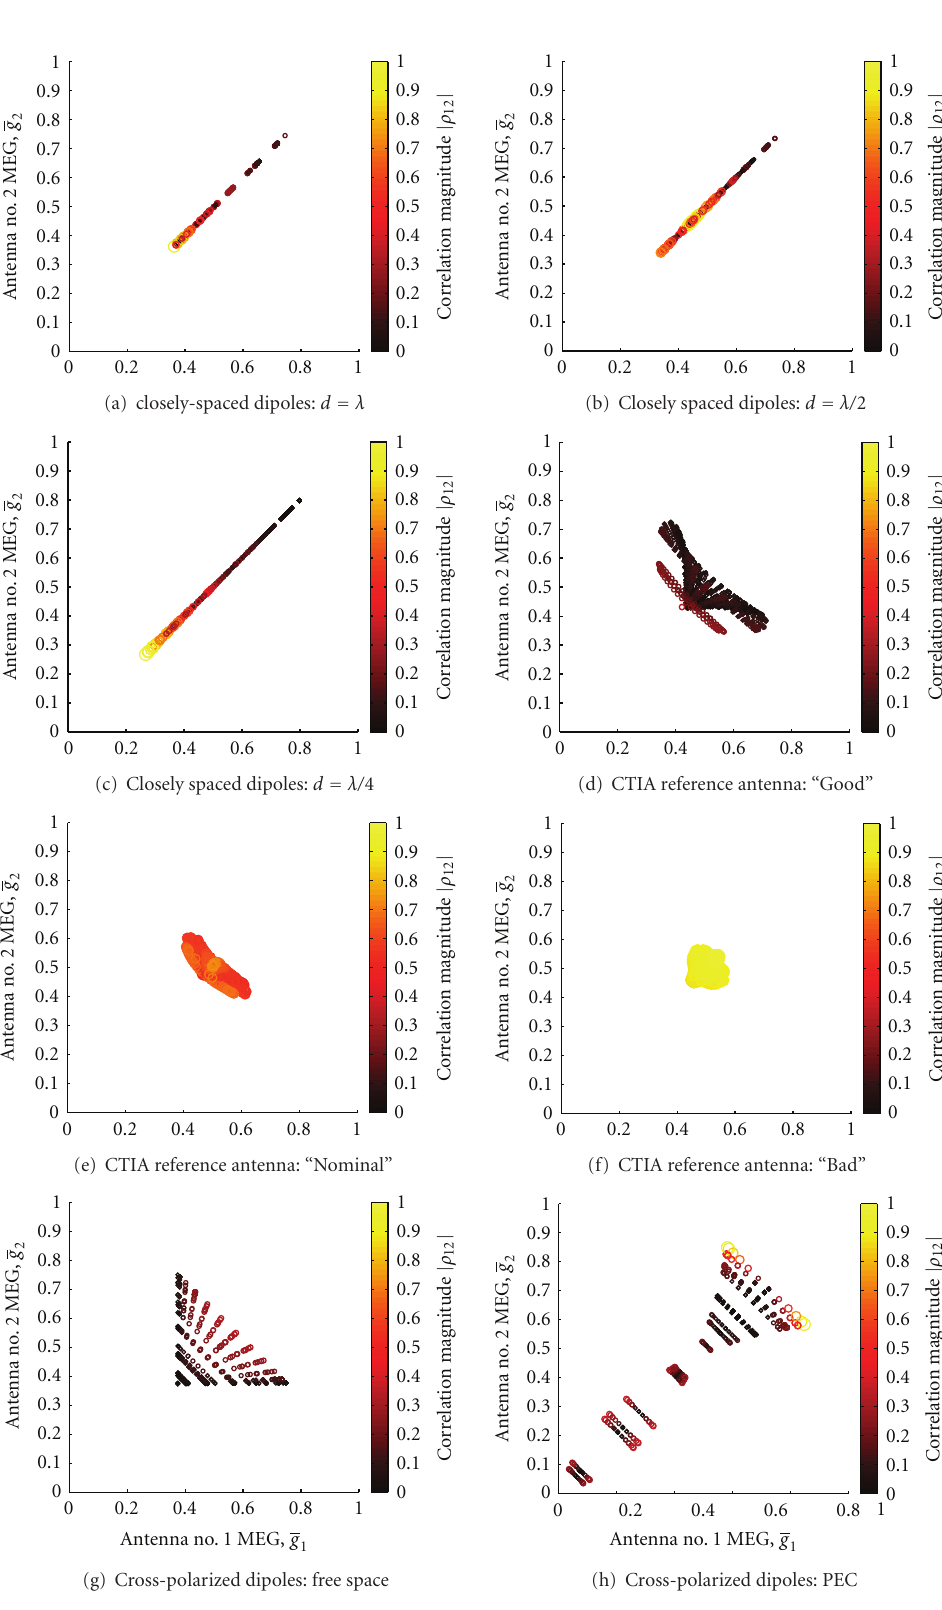
Figure 5: Scatter plots of mean e ff ective gain (MEG) and correlation coe ffi cient magnitudes for each AUT in the 2D statistically isotropic environment for N uniformly distributed orientations of the AUT. The position of each circle indicates the MEGs of the two antenna elements; the size/shade of each circle indicates the magnitude of the correlation coe ffi